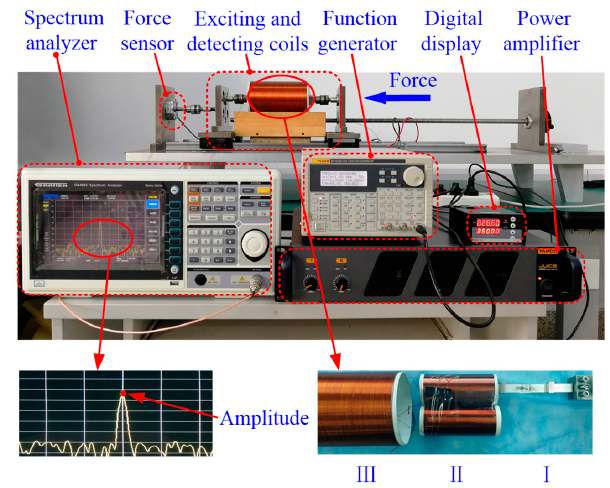
Figure 4. The experimental setup.